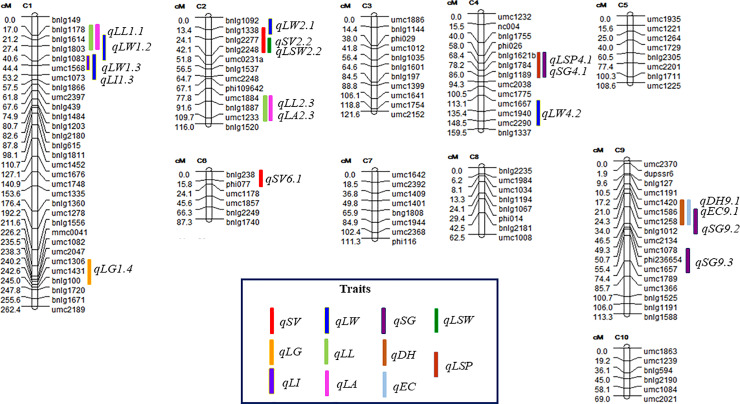
Genetic linkage map of maize representing 19 quantitative trait loci (QTL) for shoot fly resistance identified in F2:3 families derived from cross of CM143 × CM144.Putative QTL are designated by the corresponding chromosome in which they are found. The map distance is given on the left in centimorgans (cM) from the top of each chromosome and marker name is represented on the right side of the chromosome. Different color bars are used to indicate QTL for each trait. LL: Leaf length, LW: Leaf width, LA: Leaf area, LI: Leaf injury, LSW: Leaf surface wetness, LSP: Leaf sheath pigmentation, LG: Leaf glossiness, SV: Seedling vigor, SG: Stem girth, EC: Oviposition, DH: Deadheart.